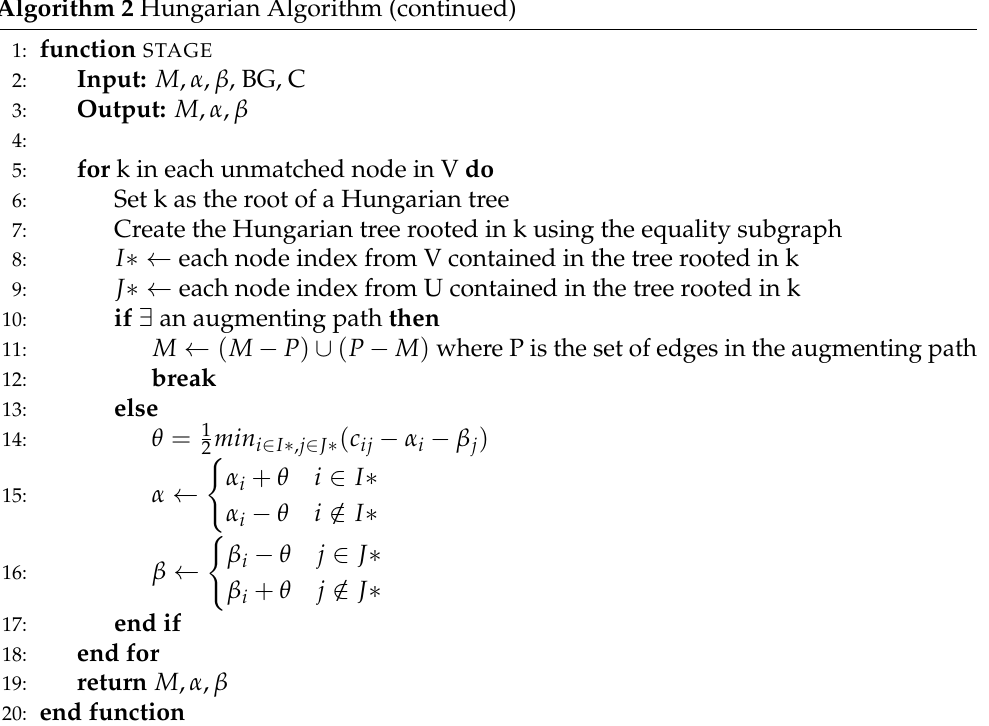
Algorithm 2 Hungarian Algorithm